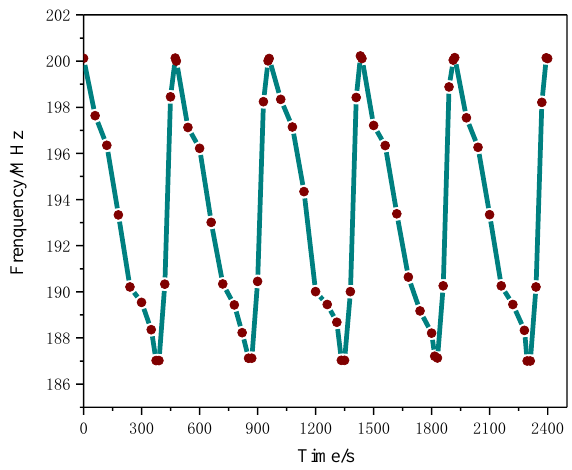
Figure 9. Gas adsorption and desorption time curves.